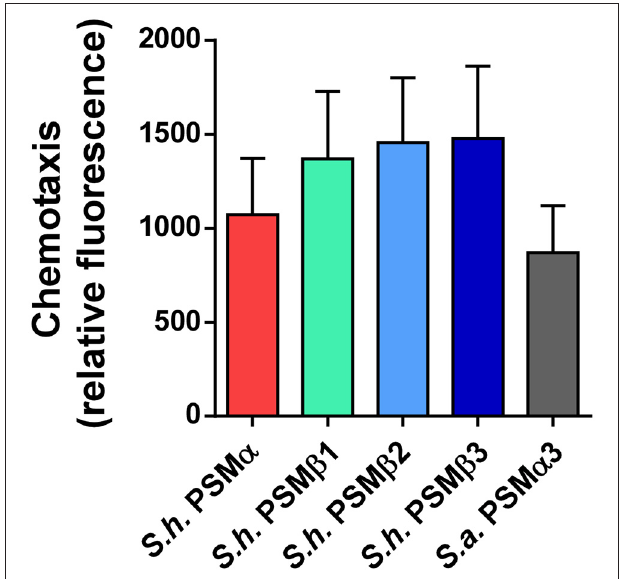
FIGURE 8 | Chemotactic activities of S. haemolyticus PSMs toward human neutrophils. Chemotactic activities of S. haemolyticus PSMs and S. aureus PSM α 3 toward human neutrophils were determined using a transwell system. PSMs were applied at a concentration of